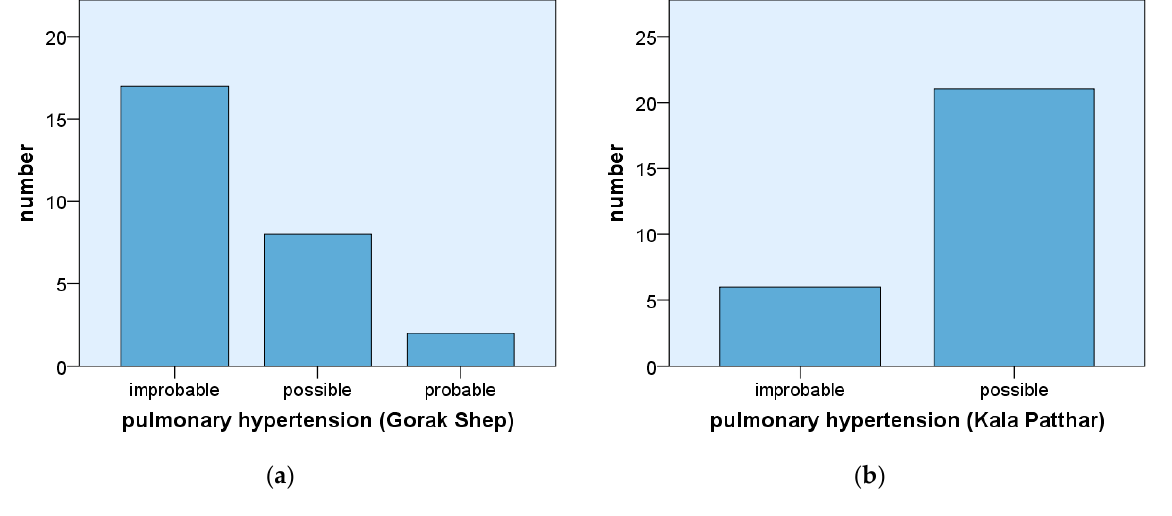
Figure 1. Pulmonary hypertension of participants at Gorak Shep ( a ) and at the summit of Kala Patthar ( b ) ( n = 27). p < 0.05